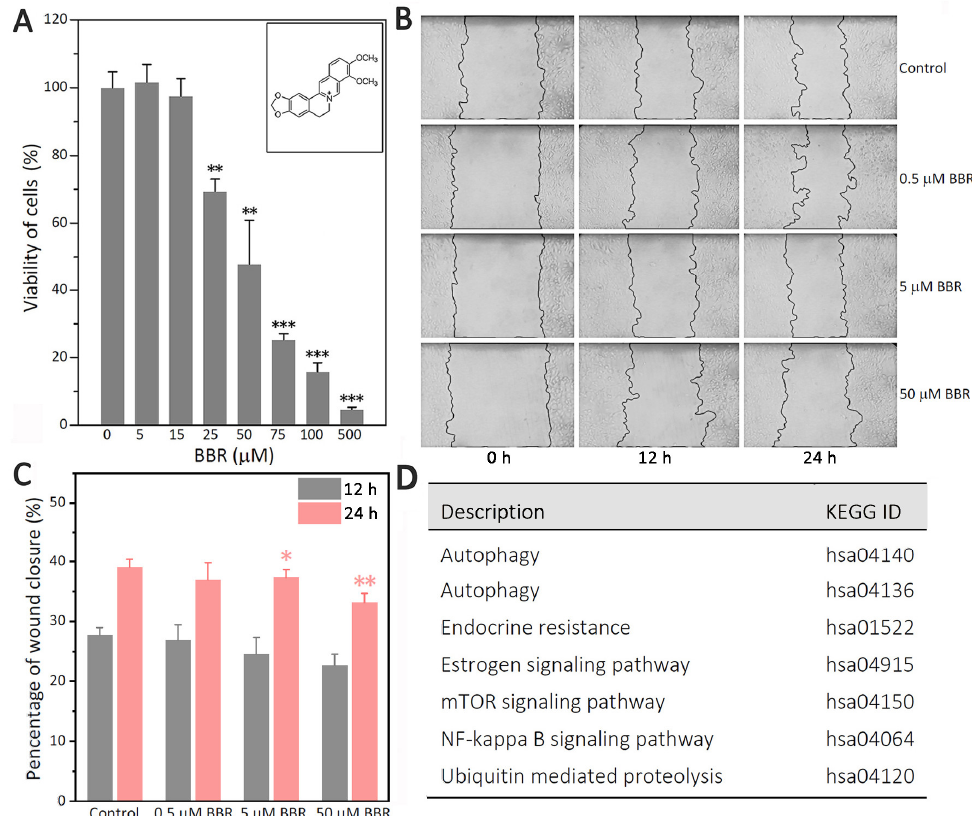
Figure 1. BBR inhibits MDA-MB-231 cells by affecting both autophagy and the estrogen signaling pathway. ( A ) MDA-MB-231 cells were treated with 0.1% DMSO as a vehicle control. The data are presented as mean ± SEM; n = 5. p < 0.01 (**), p < 0.001 (***). ( B ) The sizes of the scratched areas were observed at 0, 12, and 24 h. Representative images of each group are shown. ( C ) The percentages of wound closure are presented as mean ± SEM; n = 5. p < 0.05 (*), p < 0.01 (**). ( D ) The path analysis revealed that BBR could affect autophagy, estrogen effect, and some pathways closely related to them.